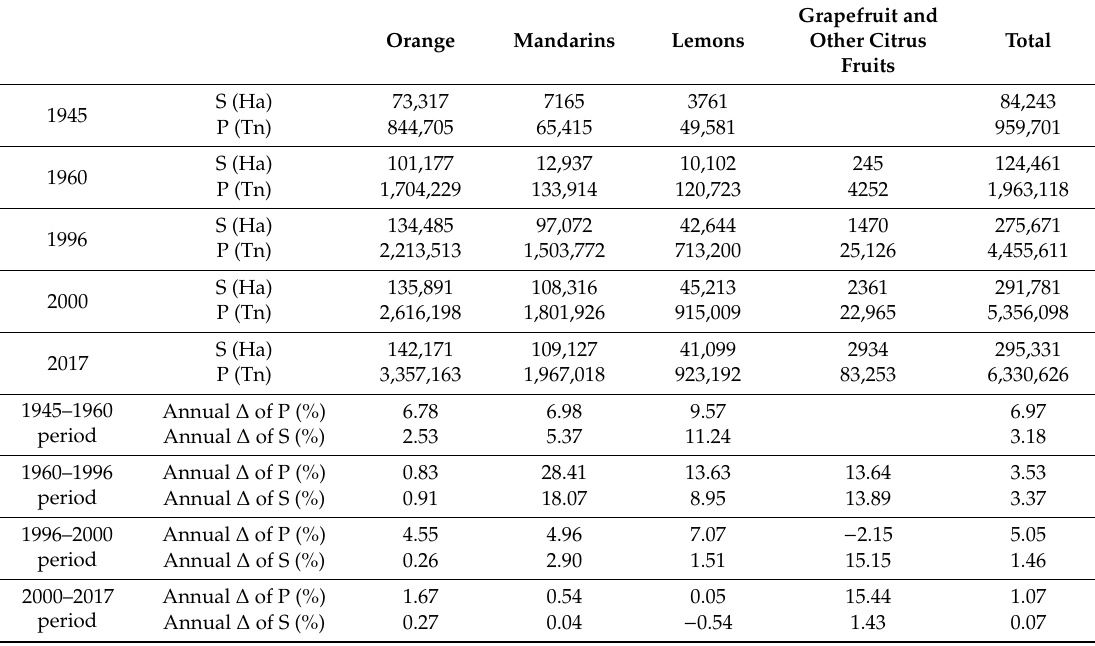
Table 2. Progression of Spanish citrus production and